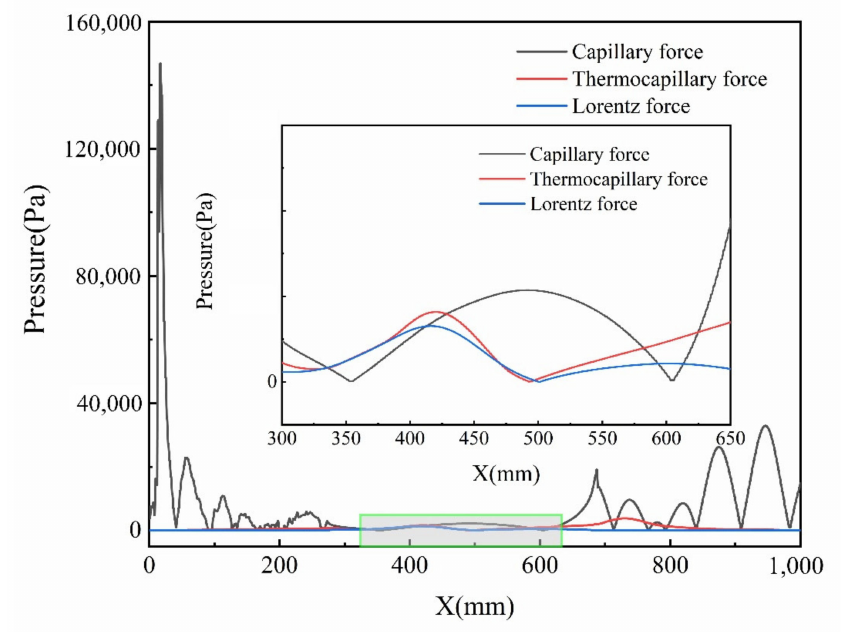
Figure 16. Variation in capillary force, thermocapillary force and Lorentz force at t = 10